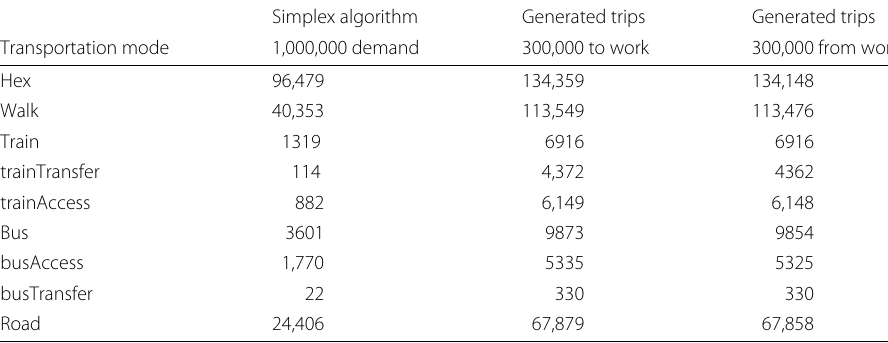
Table 8 Number of distinct edges used by each transportation mode for each flow method Simplex